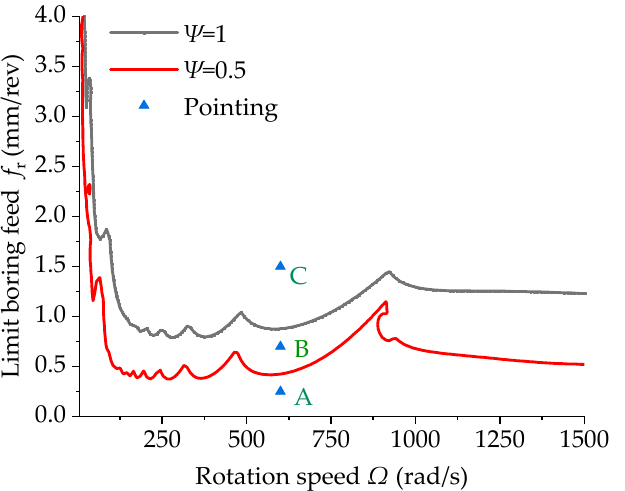
Figure 12. Stability lobe diagrams of the boring bar with different internal damping coefficients ( L/d = 10 and TR = 0).